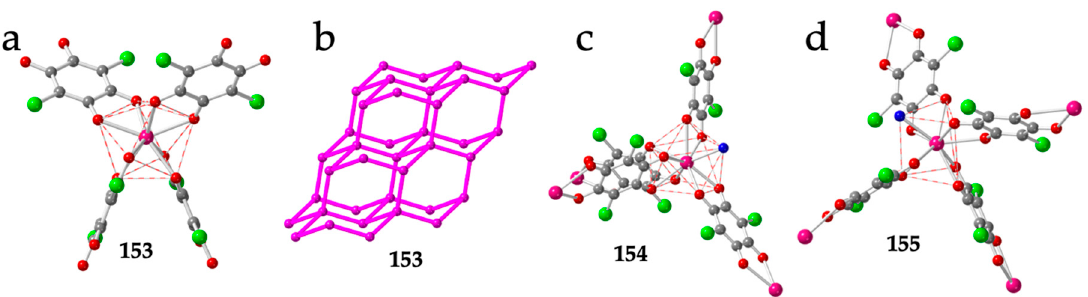
Figure 19. ( a ) Coordination environment of the Er(III) ion in compound 153 . ( b ) Distorted adamantane structure in compound 153 showing only the Er(III) ions. Pink lines represent the anilato bridges. ( c ) Coordination environment of the Ce(III) ion in compound 154 . ( d ) Coordination environment of the Ce(III) ion in compound 155 . Colour code: Ln = pink, Cl = green, C = grey, O anilato = red and O water = blue.